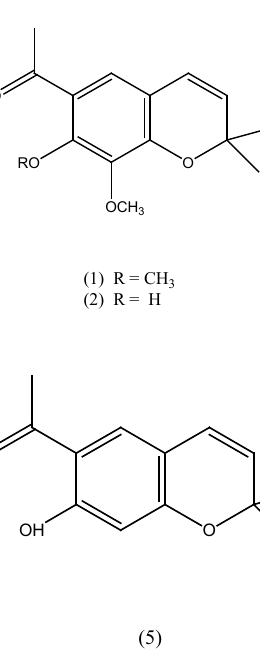
Figure 1: Chromenes isolated from A.